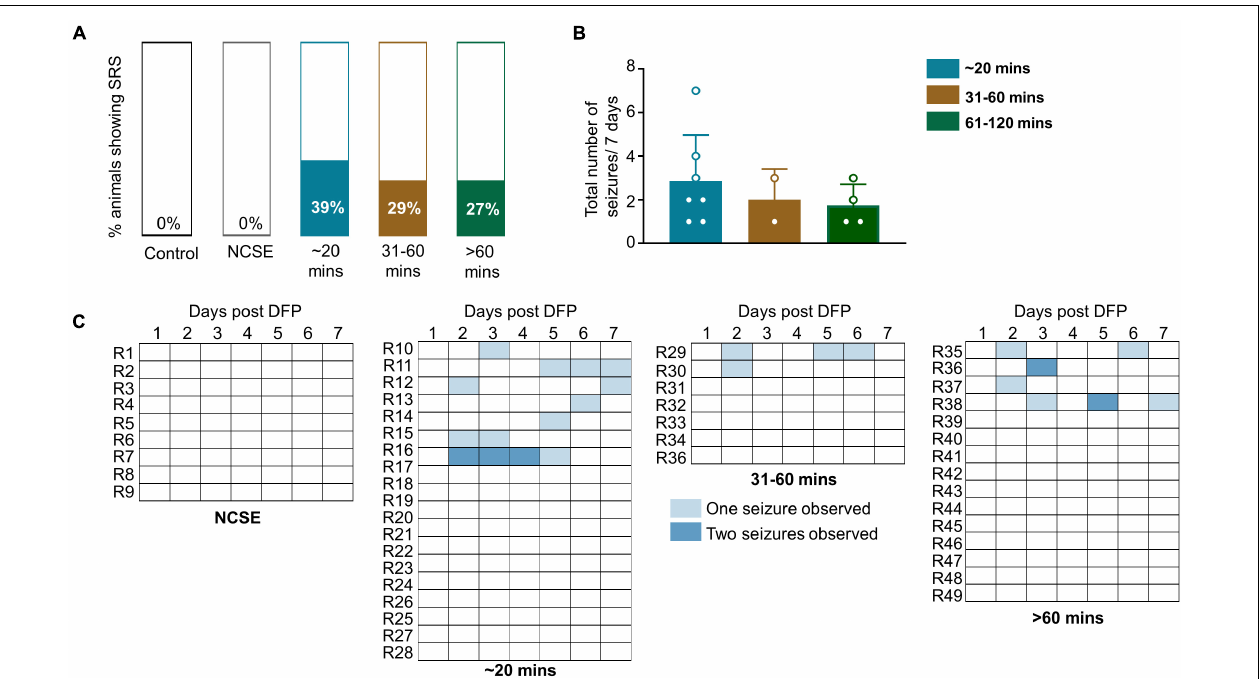
FIGURE 4 | Impact of SE duration and severity on observed spontaneous convulsive seizures while handling or soon after handling. Animals were handled twice a day for a week post-DFP. (A) 39% of animals that had 20-30-mins CS, 29% of animals with 31-60-min CS and 27% animals with > 60-min CS had spontaneous convulsive seizures. (B) There was no significant difference between the total numbers of seizures for the 7-day period between the groups (Kruskal Wallis, n = 2-4). (C) Representation of frequency of seizures over the 7-day period. NCSE, no continuous CS during SE. Error bars, standard error of the